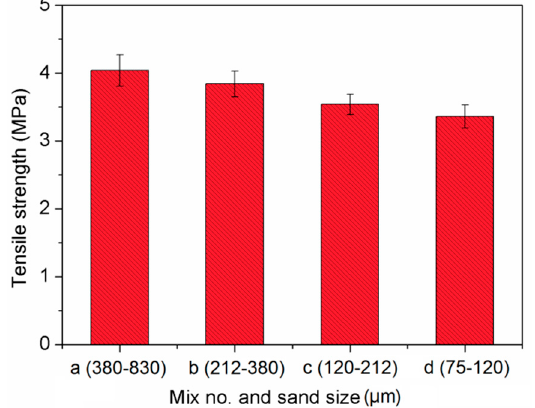
Figure 10. Tensile strength of cement-based composites.